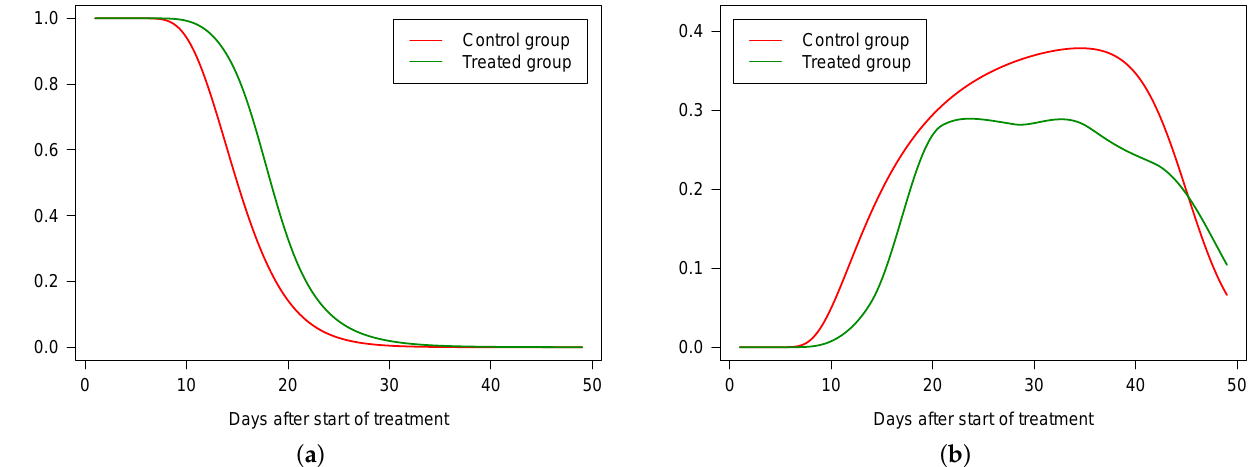
Figure 8. Survival ( a ) and hazard ( b ) functions of T 4,1 in control and treated groups.